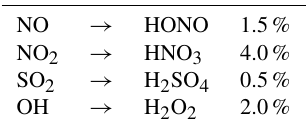
Table 2. Assumed conversion efficiencies of NO x and SO 2 to sec- ondary